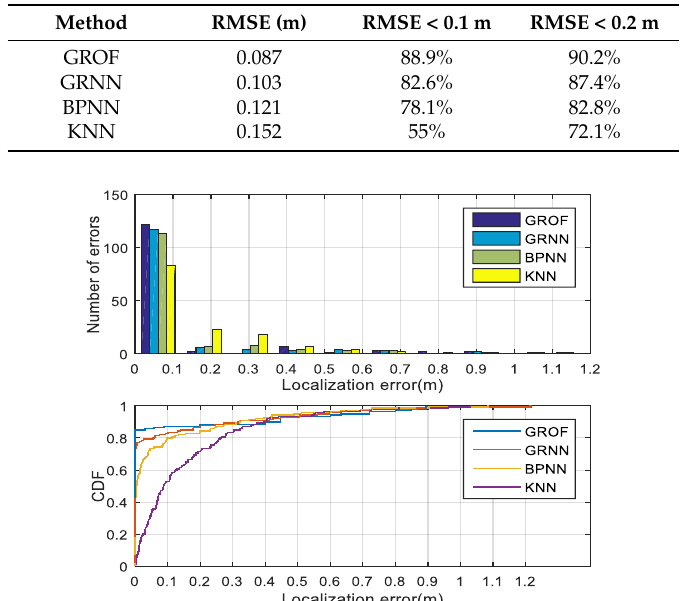
Figure 16. Localization error histogram and cumulative distribution function (CDF) of different algorithm in the line-of-sight (LOS) condition.